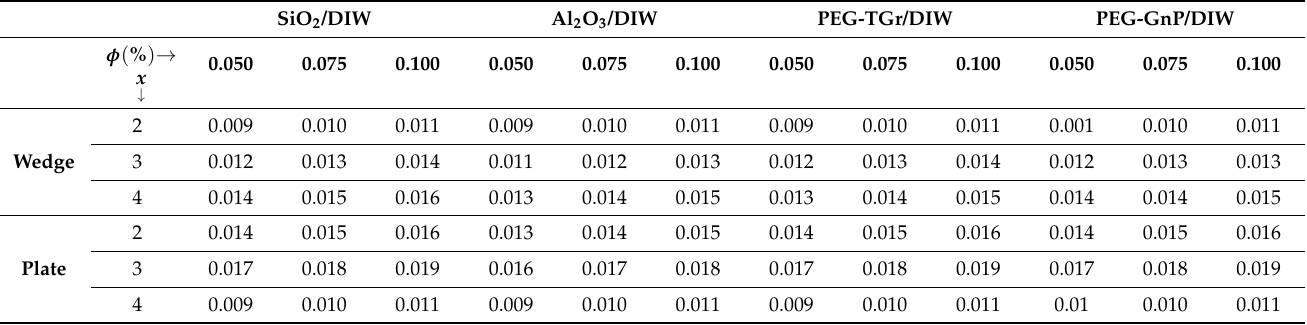
Table 12. Momentum thickness 10 × δ ∗∗ of schematic nanofluids over the wedge and plate at different nanoparticle volume fractions.